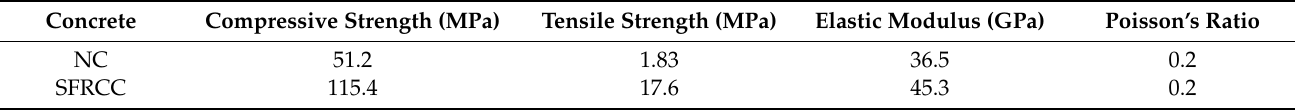
Table 3. Material performance of concrete.